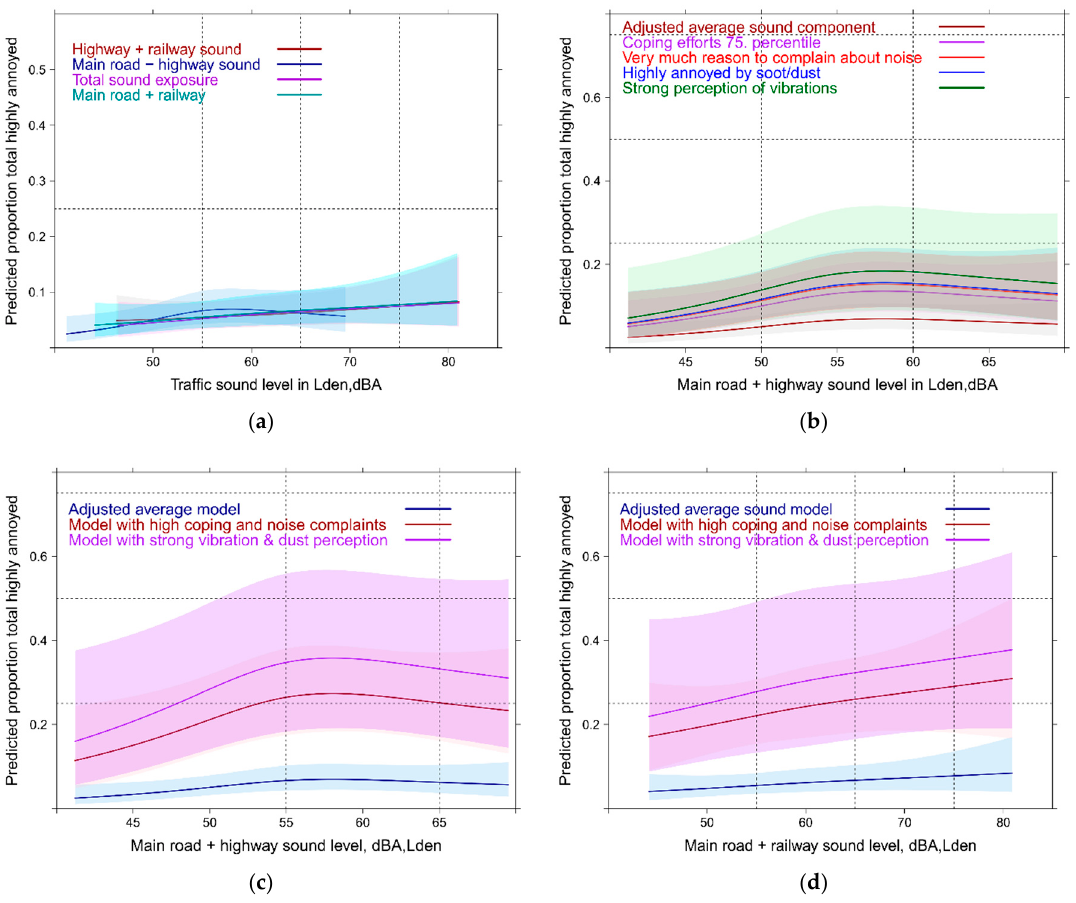
Figure 19. Predicted proportion of total annoyance associated with sound from mixed sources. ( a ) Proportion highly annoyed associated with the acoustical indicator; ( b ) The relative importance of predictors for the proportion highly annoyed associated with a road exposure combination; ( c ) The relative importance of predictor combinations for the proportion highly annoyed associated with a road exposure combination; ( d ) The relative importance of predictor combinations for the proportion highly annoyed associated with a main road-railway exposure combination. Models are adjusted for age, gender, education, health status. Depending on the predictors shown, adjusted for all other predictors not shown in the graph (complaints about community soundscape and air pollution, perceived vibration, perceived dust/soot from road, coping, anger at traffic load).